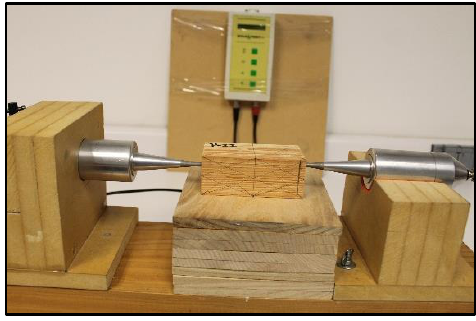
Figure 4. Ultrasound tests in the longitudinal